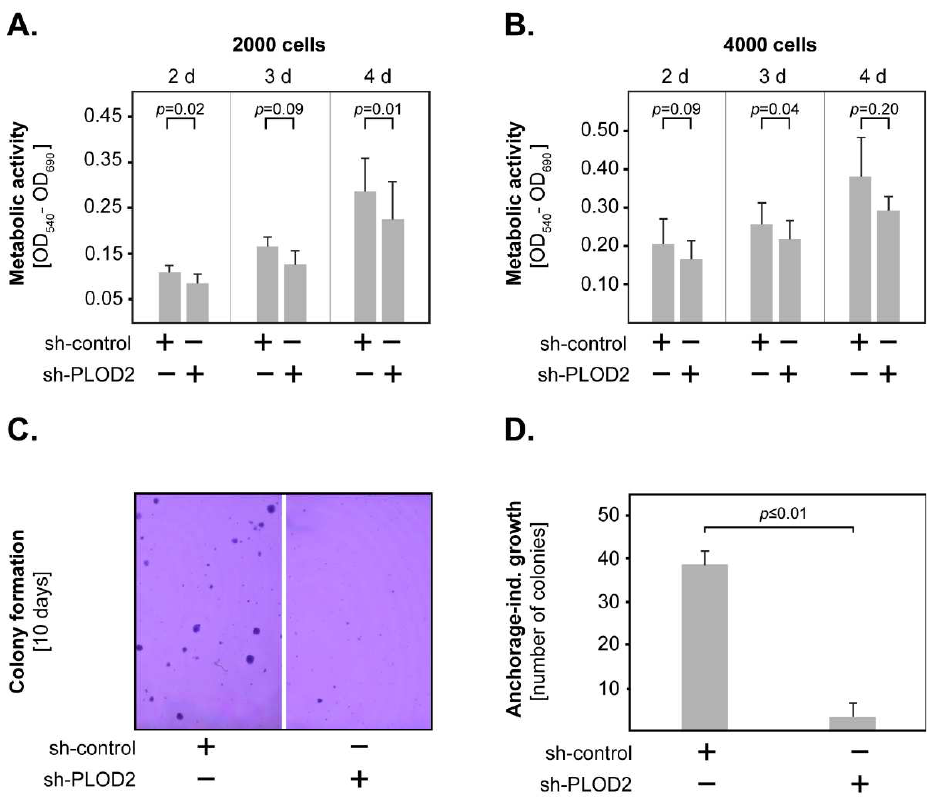
Figure 4. PLOD2 and GBM proliferation. PLOD2 knock-down reduced the metabolic activity of H4 GBM cells, as indicated by the MTT assay using ( A ) 2000 cells and ( B ) 4000 cells. ( C ) Representative micrographs of colonies generated by sh-control and sh-PLOD2 cells after 10 days of culture in low-gelling agarose. ( D ) PLOD2 knock-down significantly inhibited the anchorage-independent growth of H4 cells. Shown are the means + S.D. of at least three independent experiments per assay. In all studies, statistical analysis was performed with the paired t -test.